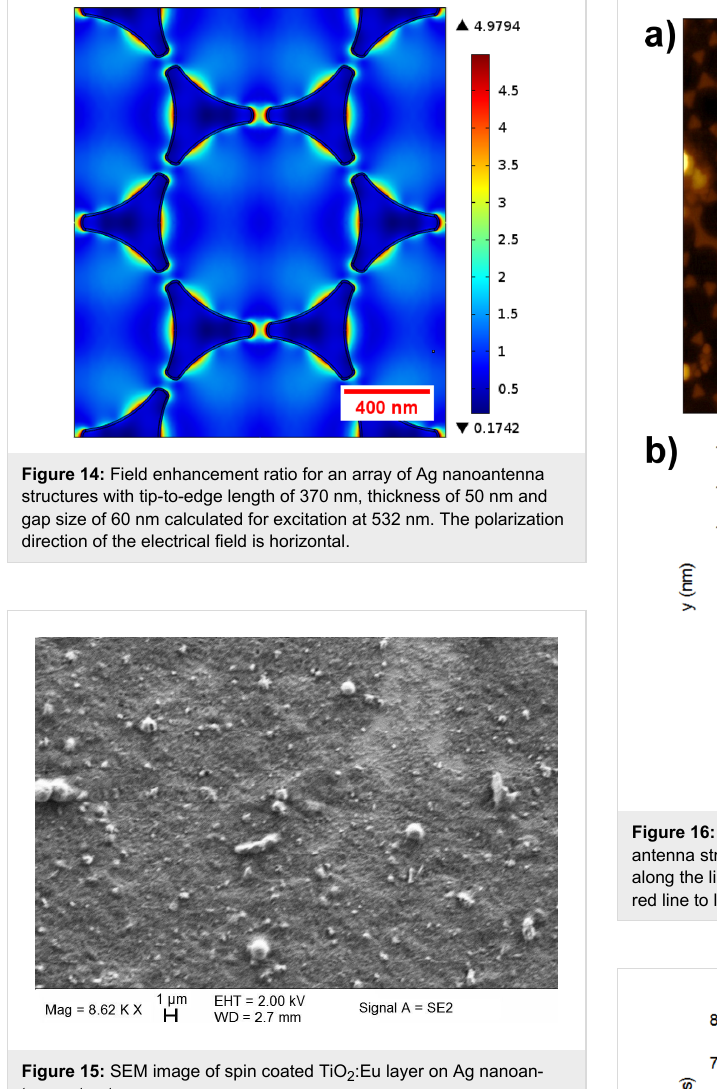
Figure 15: SEM image of spin coated TiO 2 :Eu layer on Ag nanoan- tenna structures.